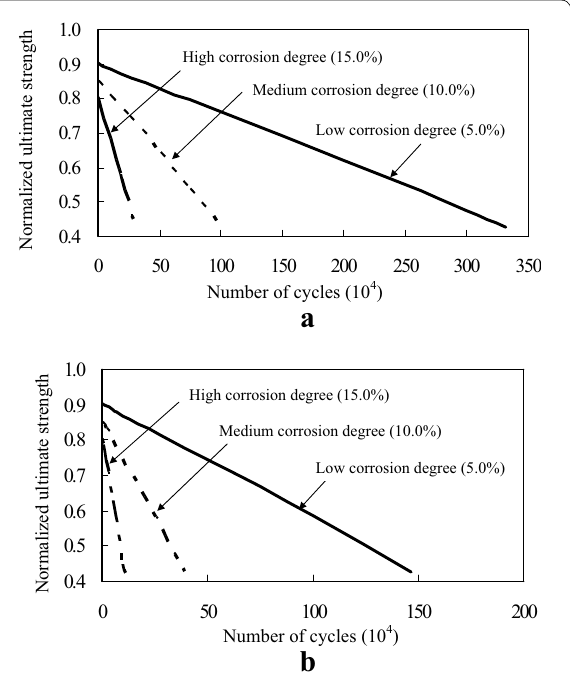
Fig. 11 Fatigue life versus average degree of corrosion and a/b.